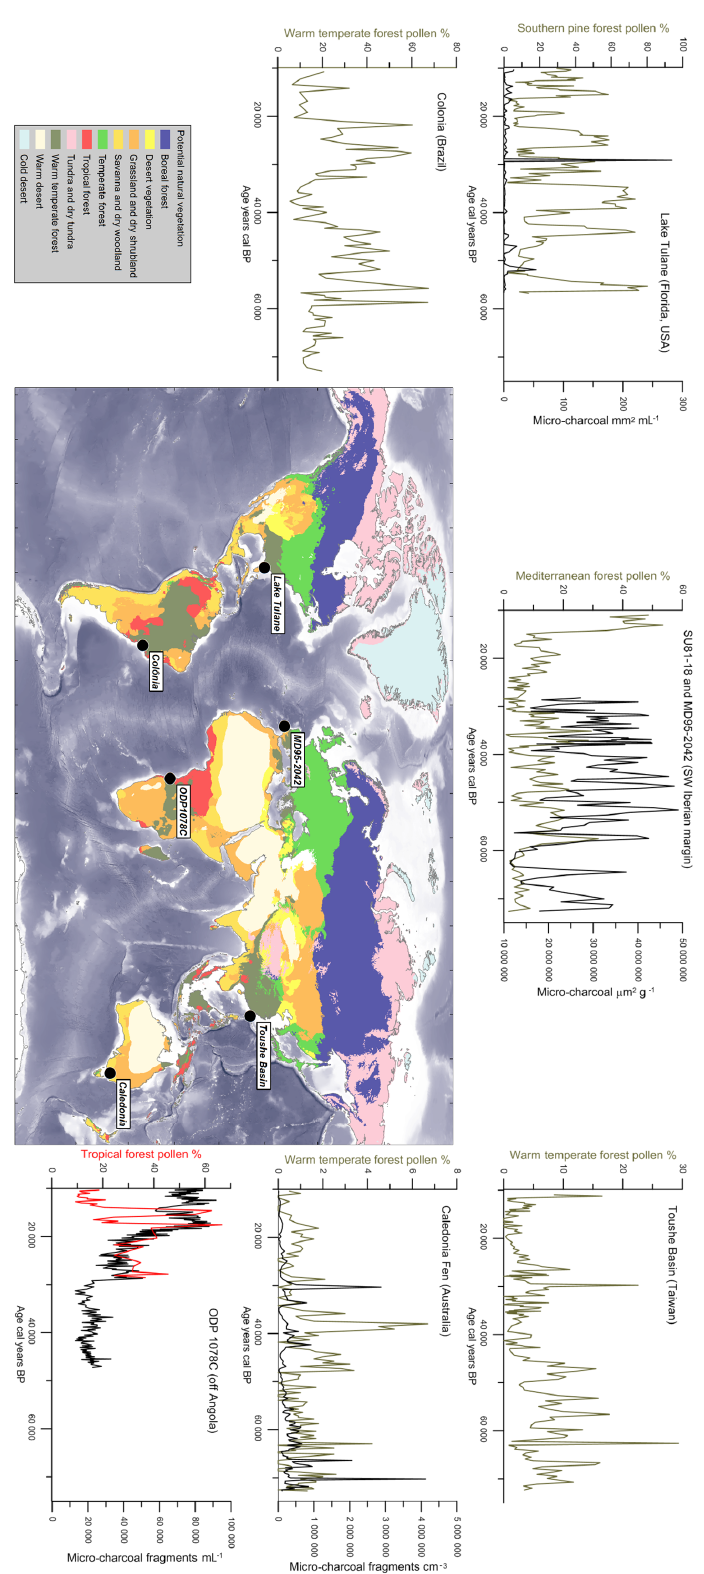
Figure 5. Pollen (green: warm temperate forest; red: tropical forest) and charcoal (black) curves from six sites plotted against the harmonized age